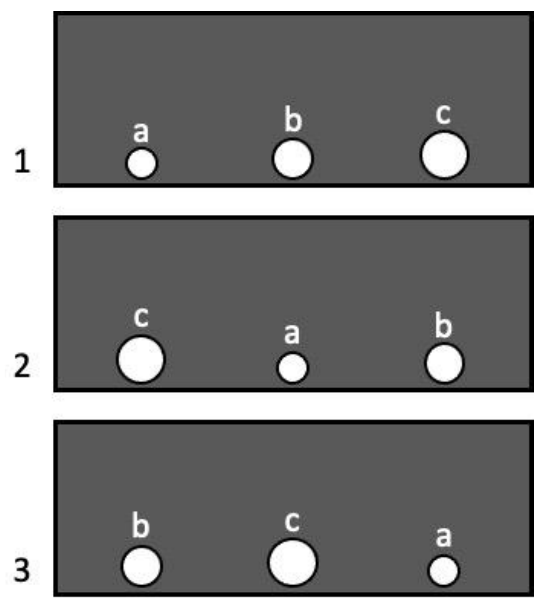
Figure 3. Location of holes during Experiment 1: 1, 2, 3—experimental trials; a—small hole (Ø 70 mm), b—medium hole (Ø 90 mm), c—large hole (Ø 110 mm).